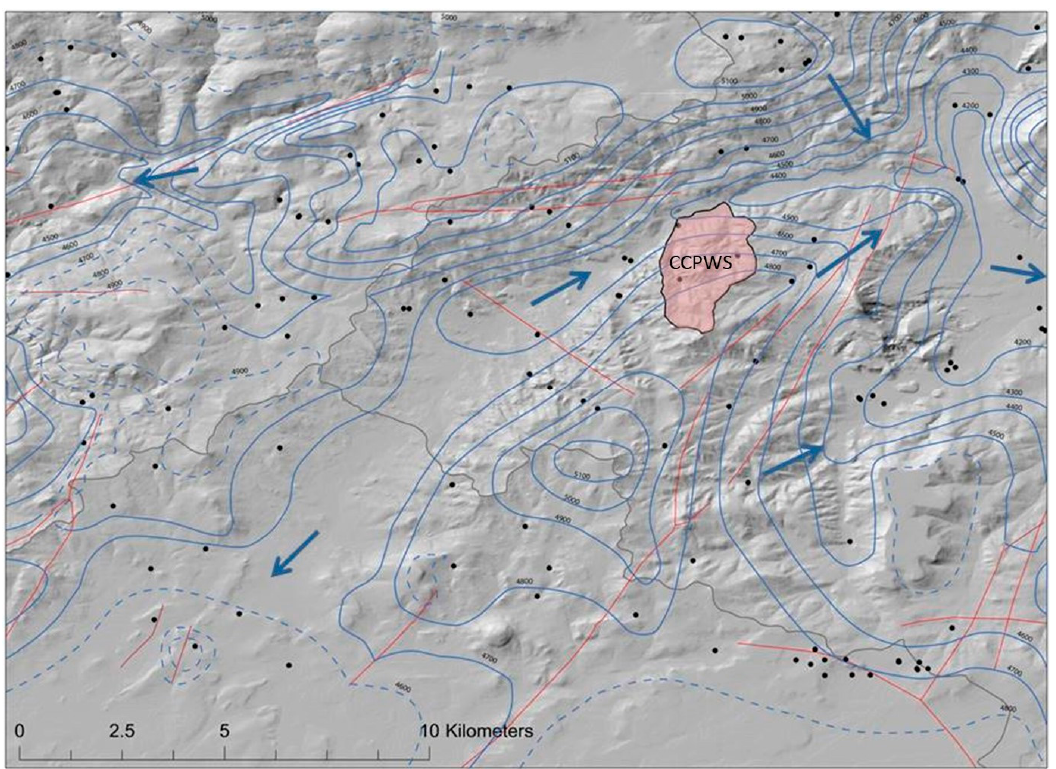
Figure 4. Potentiometric surface map created in 2018, based on static groundwater level and spring elevation data, showing groundwater level contours (solid blue curves), the direction of flow (blue arrows), and well and spring locations (black dots). Dotted curves indicate a higher degree of uncertainty on delineating groundwater level contours. Red curves indicate geologic faults.